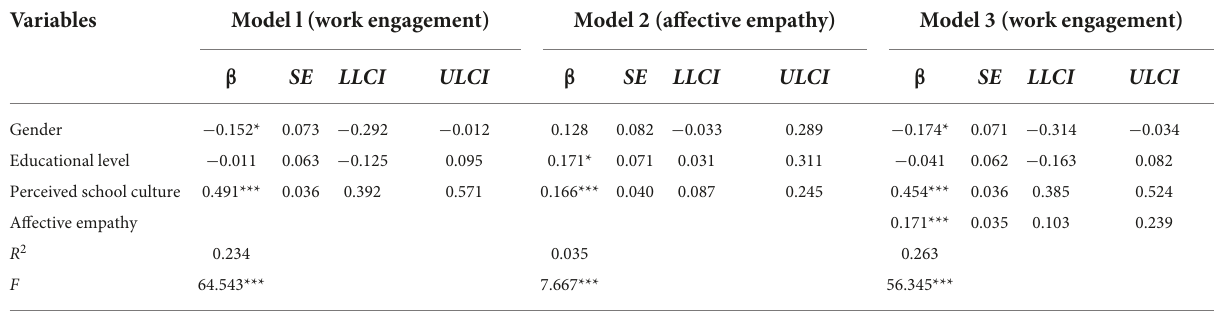
TABLE 2 Testing the mediation effect of perceived school culture on work engagement via affective empathy.